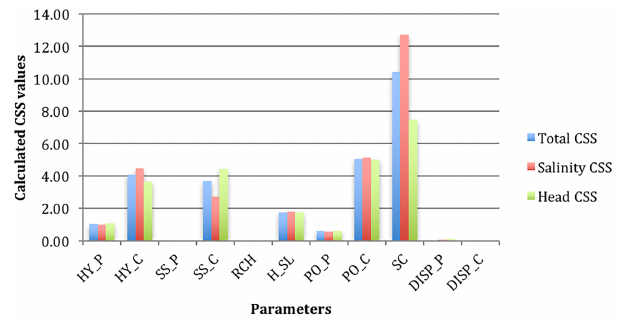
Figure 4. The CSS (composite scaled sensitivity) values of all pa- rameters with respect to simulations in the conduit (layer no. 29) in the local sensitivity